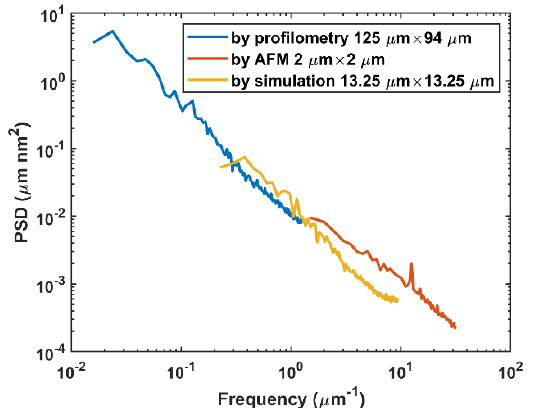
Figure 15. PSD for profilometry (125 μ m × 94 μ m, 640 × 480 sampling points), AFM (2 μ m × 2 μ m, 256 × 256 sampling points), and simulated surface (13.25 μ m × 13.25 μ m, 500 × 500 sampling points) for Si<111>.